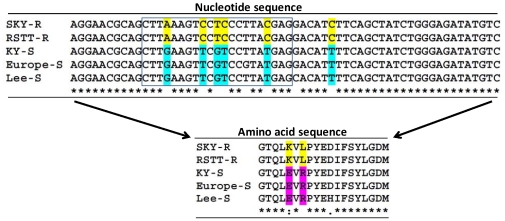
Comparisons of nucleotide and amino acid sequences between two resistant strains (SKY-R and RSTT-R) and three susceptible strains (KY-S, Europe-S, and Lee-S) of European corn borer.The rectangular block on the nucleotide sequence indicates the forward primer.